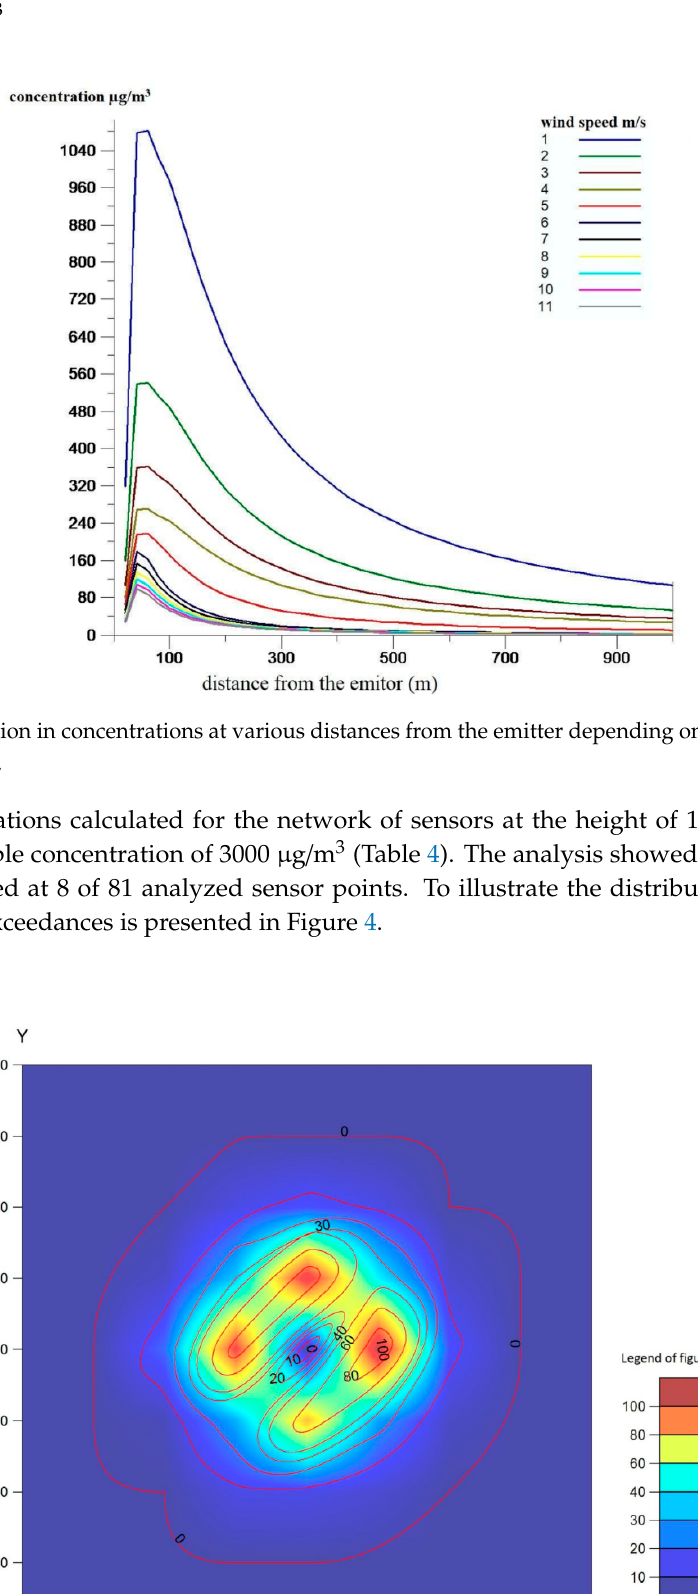
Table 4. Calculated concentrations of aliphatic hydrocarbons in the network of sensors at a height of 10 m.